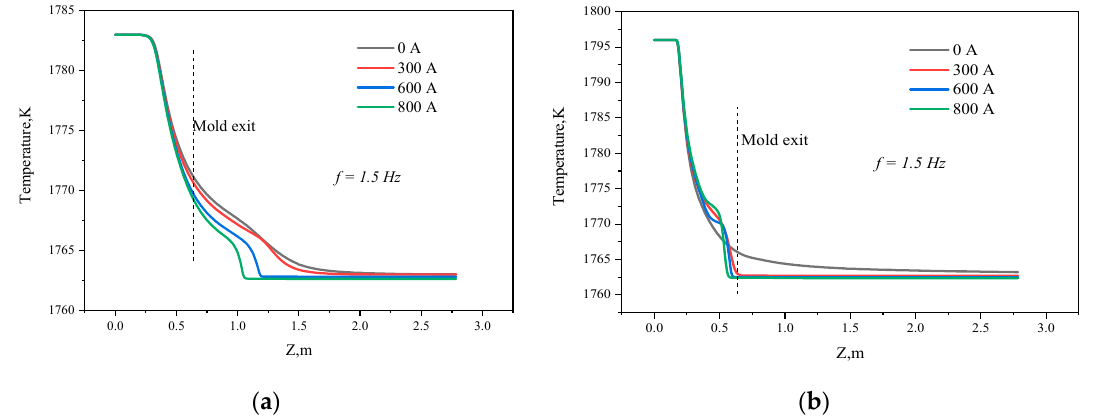
Figure 8. Temperature distribution of molten steel on the strand centerline along the casting direction: ( a ) single-port nozzle; ( b ) five-port nozzle.